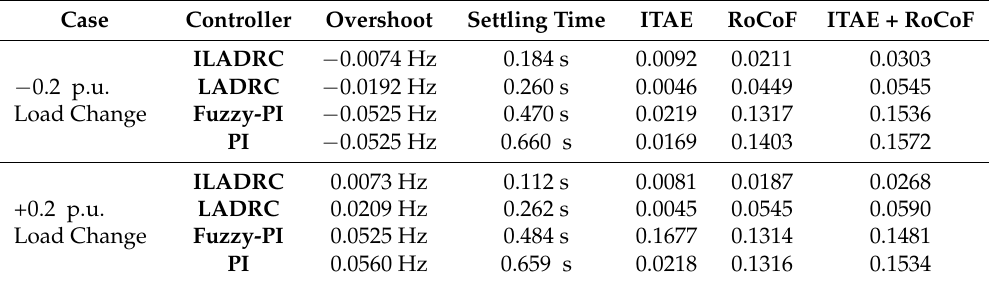
Figure 10. Transient response of system frequency deviation with − 0.2 p.u. change of load demand. Table 7. Performance comparison with ILADRC, LADRC, PI and Fuzzy-PI